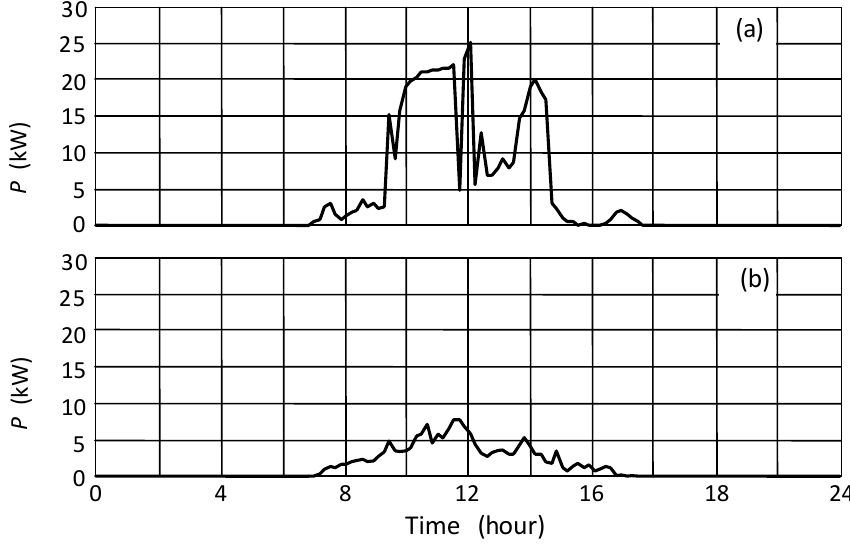
Figure 6. Variation of PV system power output during: ( a ) sunny day and ( b ) cloudy day.